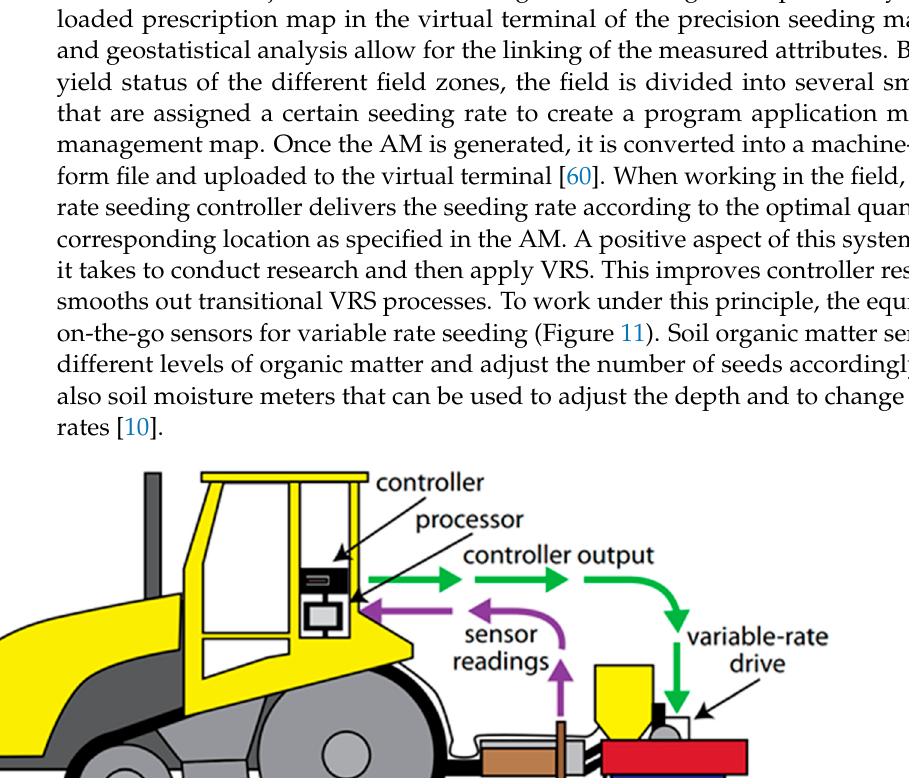
13 of 24 Figure 10. Veris multi sensor platform (MSP) with the Soil pH Manager: 1—soil sampler shoe; 2— parallel linkage; 3—adapter; 4—scraper; 5—pH sensors; 6—water supply with nozzles; 7—water pump; 8—row cleaner; 9—furrow closer; 10—controller; 11—data recorder; 12—sensor of apparent